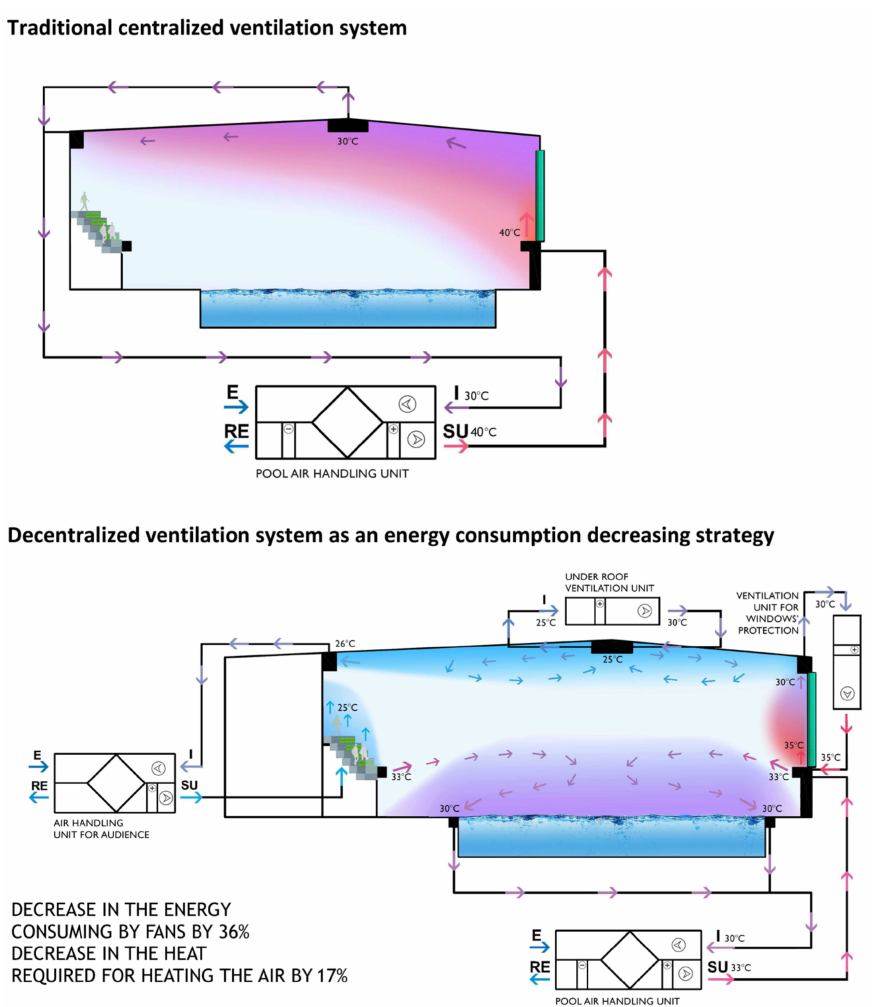
Figure 10. Traditional and decentralized ventilation systems for swimming pool analyzed in